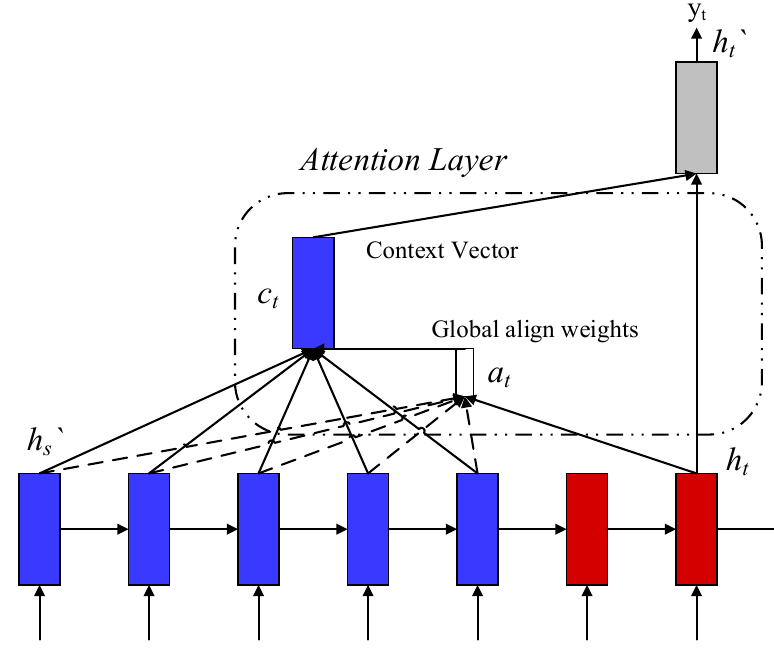
Figure 2. The structure and functionality of a global-attention mechanism.